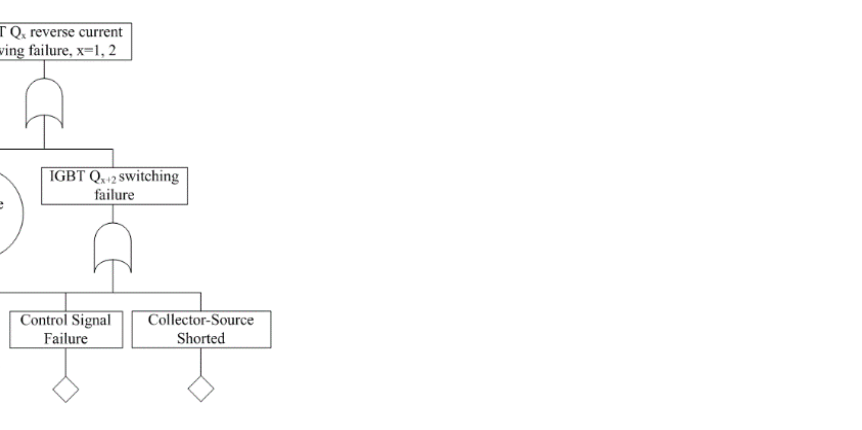
Figure 4. Sub fault tree for Simultaneous C 1 and C 2 charging function failure.